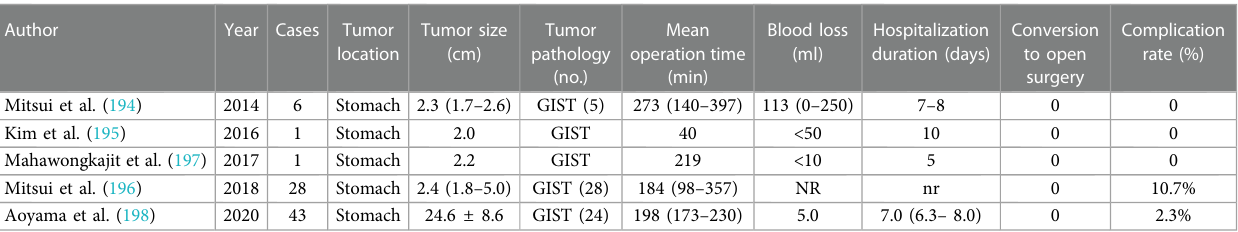
TABLE 15 Research studies of the NEWS technique.